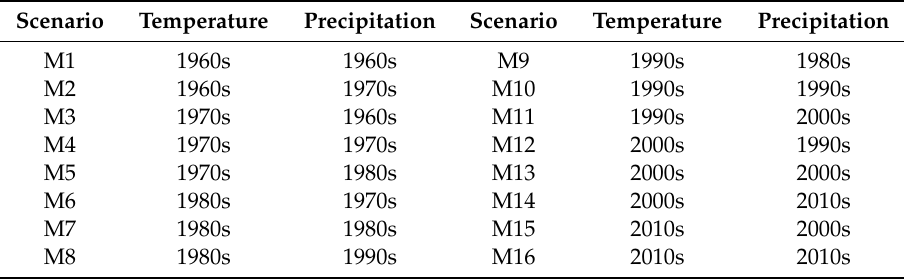
Table 1. The list of di ff erent model scenarios used to evaluate the impacts of climate variability on the hydrology components of Luanhe River